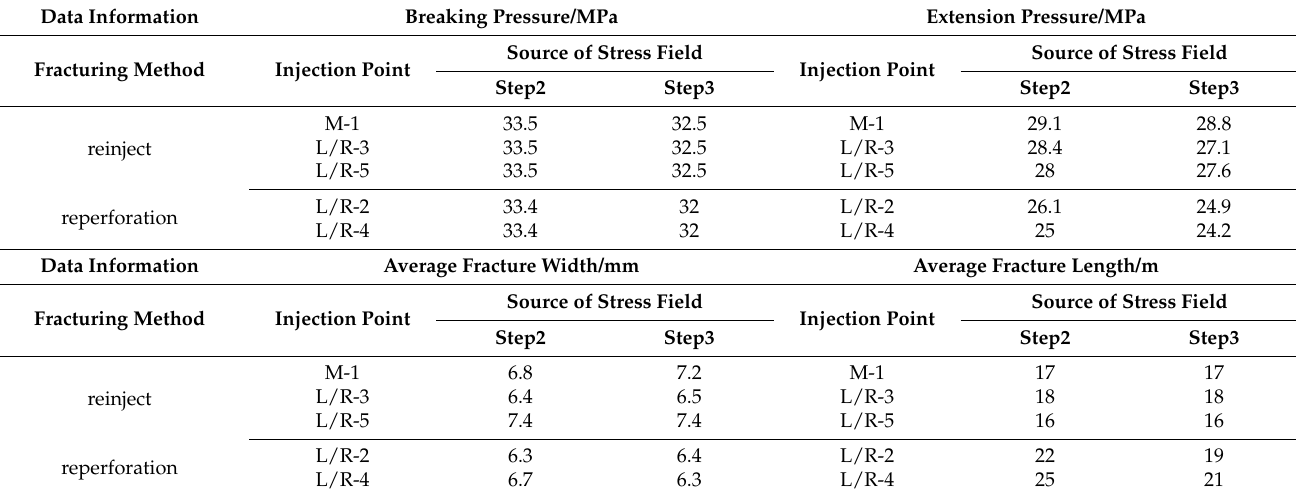
Figure 11. Results of reperforation hydraulic fracturing. The formation was reperforated in the middle of the five fractures of the initial fracturing, and the initial fracture was blocked by the temporary plugging technology, resulting in only four fractures during the refracturing. Table 3. Data statistics of